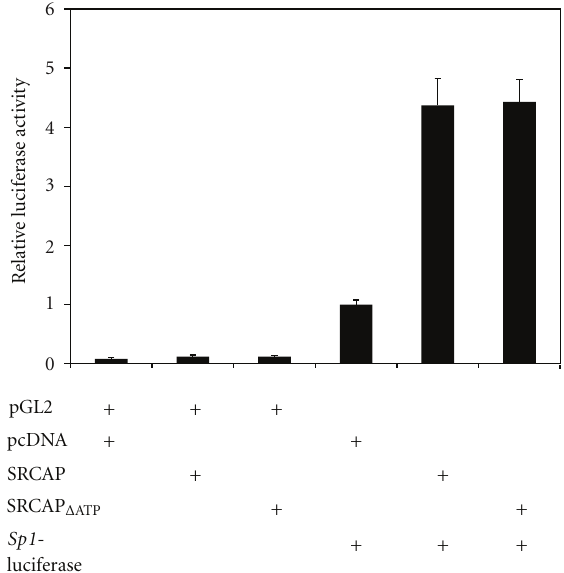
Figure 6: SRCAP mediates transcriptional activity independent of H2A.Z deposition. HeLa cells were transiently transfected with 300 μ g of Sp-1 -luciferase reporter gene plasmid or the control pGL2 luciferase reporter gene plasmid and, where indicated, with 1000 η g of plasmid expressing wild-type SRCAP or the SRCAP mutant or the control vector pcDNA 3.1. The relative luciferase activity is reported compared to the luciferase activity observed in cells transfected with pGL2- luciferase and pcDNA 3.1. The graph represents the mean result and standard error of three or more independent transfection